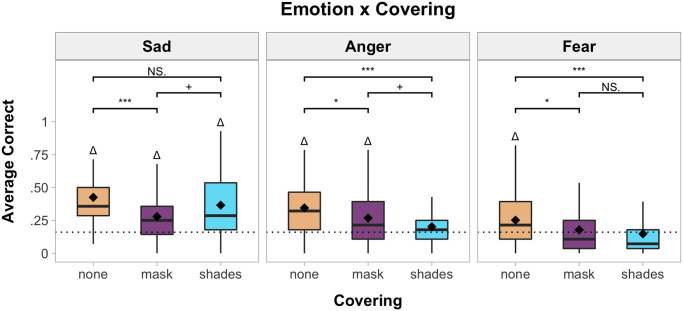
Boxplots for the emotion x covering interaction.* indicates comparisons between covering types for each emotion (*p < .05, ***p < .001, +p < .10, NS = not significant with Bonferroni-Holm corrections). The dotted line indicates chance responding (1/6). Δ indicates that accuracy was significantly greater than chance (p < .05 with Bonferroni-Holm corrections).